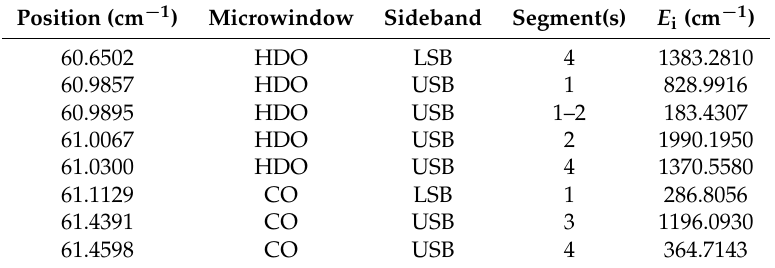
Table 3. Various ozone lines corresponding to the three selected FIR microwindows. Only the most significant ozone transitions are listed. Information about the sideband and segment where the O 3 line lies is given. E i represents the energy of the lower state for the O 3 transition. LSB and USB stand for the lower and upper sidebands, respectively. The associated line parameters (position of line center and E i ) are extracted from the HITRAN